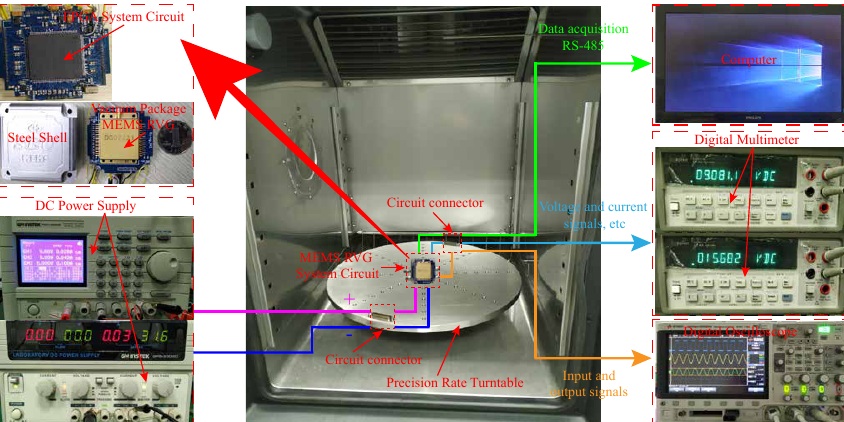
Figure 9. MEMS DRG circuit and experimental equipment.